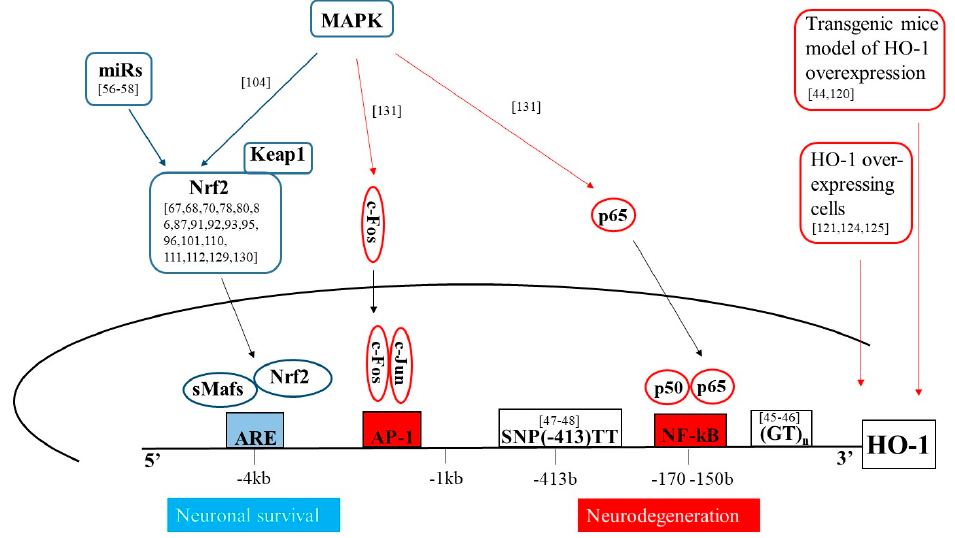
Figure 2. Schematic representation of the main pathways involved in HO-1 mediated neuroprotection or neurodegeneration. The blu arrows and shapes represent signal pathways involved in HO-1 regulation in neuronal survival; the red arrows and shapes represent signal pathways involved in HO-1 regulation in neurodegeneration.